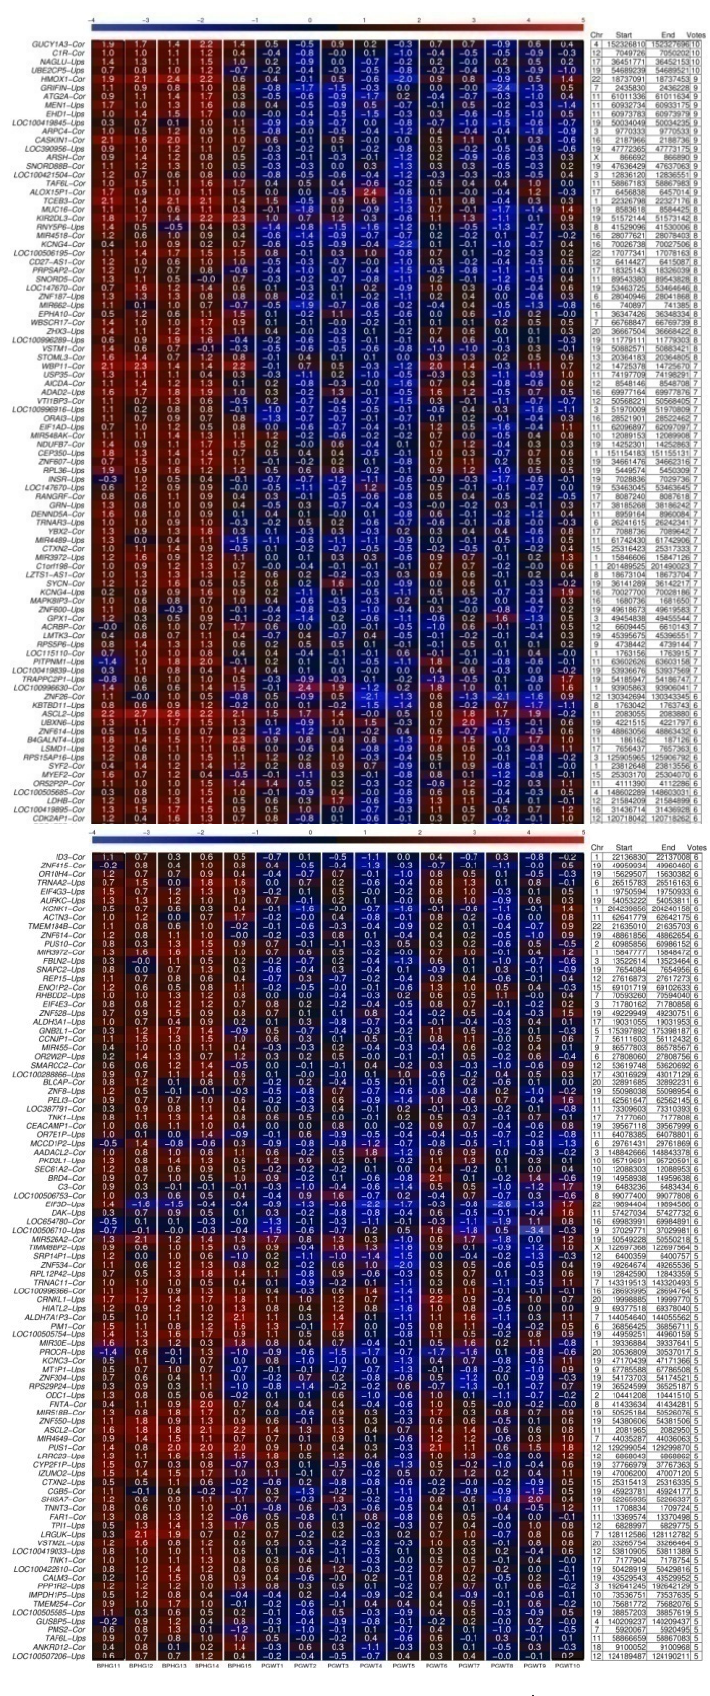
Figure 2. DNA methylation heat maps of CpG-rich 5 ′ gene regions in BPH samples and PCa tissue samples. A total of 5 tissue samples from BPH prostate glands and 10 PCa tumor tissue samples were used (tumor). The top 186 most voted by our democratic method differentially methylated loci out of 370 hypomethylated regions found are presented from left to right. Both panels corre- spond to results from the same primary PCa tissue samples of various tumor stages and grades